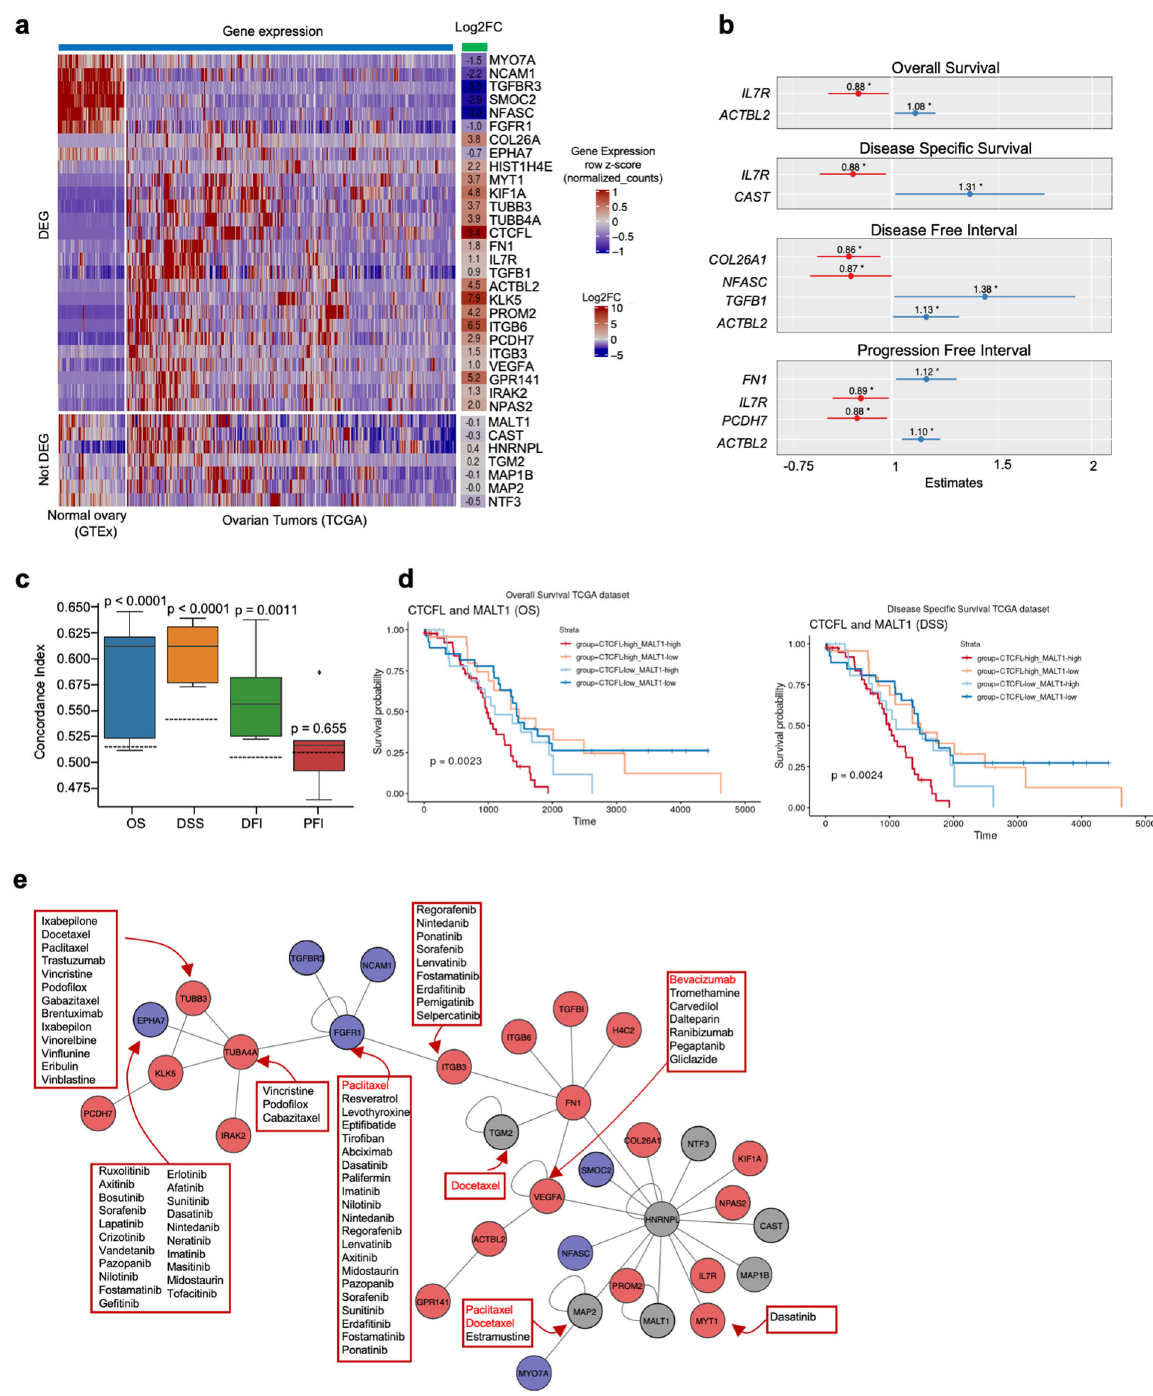
Fig. 3 Evaluation of prognosis and druggability of CTCFL-regulated genes in ovarian cancer tumor samples. a Relative expression of the 34 CTCFL-regulated candidate genes in normal and tumor samples (left panel) and their corresponding fold change (right panel). Genes are grouped into DEGs ( p -adj < 0.05) or not DEGs ( p -adj ≥ 0.05). b Survival analysis with Cox PH model using four survival data: overall survival (OS), disease-speci fi c survival (DSS), and progression-free survival (PFI). c Average Concordance Index (CI) obtained with the gene expression of the 34 candidate genes using the random survival forest (RSF) model. The dashed horizontal line indicates the average CI of random sets of genes for each survival dataset. d Kaplan – Meier plots of MALT1 (top relevant gene found by OS and DSS RSF models) in combination with CTCFL expression. e CTCFL -regulated protein interaction network found in vitro depicting the druggable targets that are differentially expressed in tumor samples versus normal tissue (TCGA vs GTEx). Red and blue nodes indicate genes upregulated and downregulated in tumor vs normal, respectively. Targeting drugs are shown in red boxes, red drug labels indicate drugs currently clinically used for OC